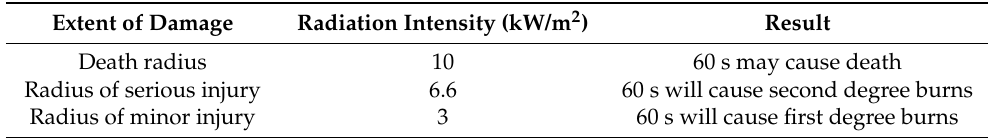
Table A1. Personnel thermal radiation intensity